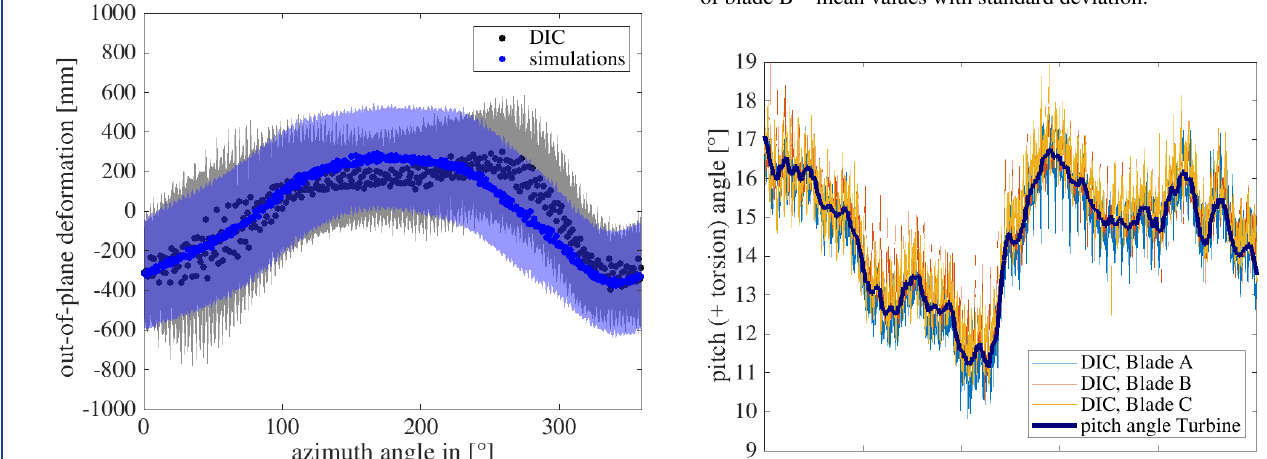
Figure 22. Comparison of IP deformation of DIC and simulations of blade B – mean values with standard deviation.